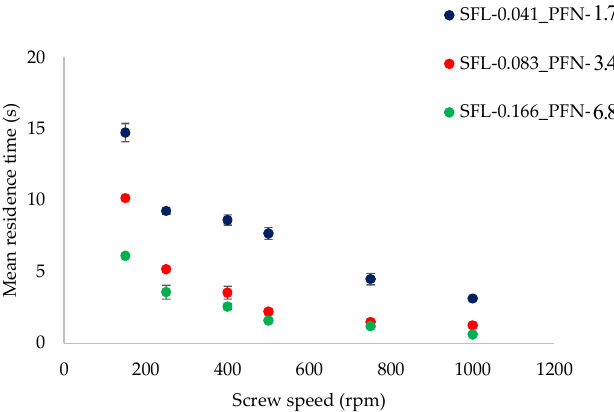
Figure 2. Mean residence time of lactose at different specific feed load (SFL)–powder feed number (PFN) at varying screw speed (L/S 0.048).